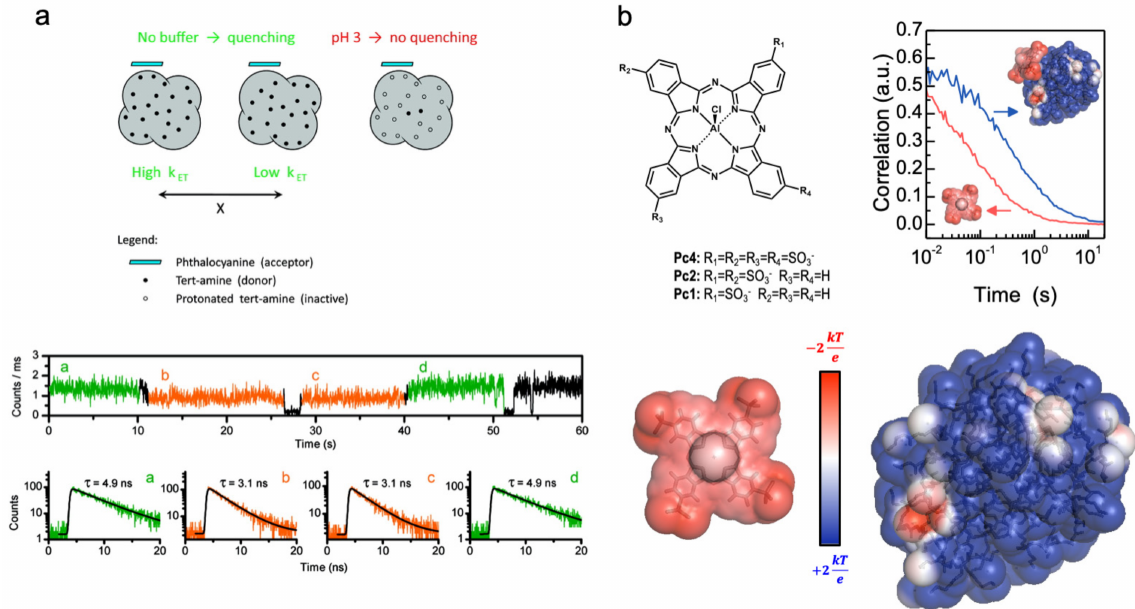
Figure 1. ( a ) Scheme of phthalocyanine-dendrimer complex (top) highlighting the tetrapyrrolic macrocycle (cyan) at the dendrimer surface (grey). The phthalocyanine’s fluorescence is quenched by the dendrimer’s tertiary amine donors (closed dots) except when protonated at low pH (open dots) in an aqueous medium or in hydrophilic films. Example of a single-molecule fluorescence trace of phthalocyanine-dendrimer emission (bottom) showing concomitant changes in intensity and lifetime attributed to dynamic heterogeneity in photoinduced electron-transfer due to fluctuations in donor–acceptor distance. Adapted with permission from [21]. Copyright 2010 American Chemical Society. ( b ) Chemical structure of AlPCS 4 phthalocyanine and fluorescence auto-correlation curves of free AlPCS 4 and of its complex with the PAMAM dendrimer G4 (top). The electrostatic potential on the solvent accessible surface of AlPCS 4 (left side) and of the PAMAM G4 dendrimer (right side) showing all terminal amines protonated and condensed chlorine counterions—red and blue indicates negatively and positively charged regions, respectively. Reproduced from [24] with permission from the PCCP Owner